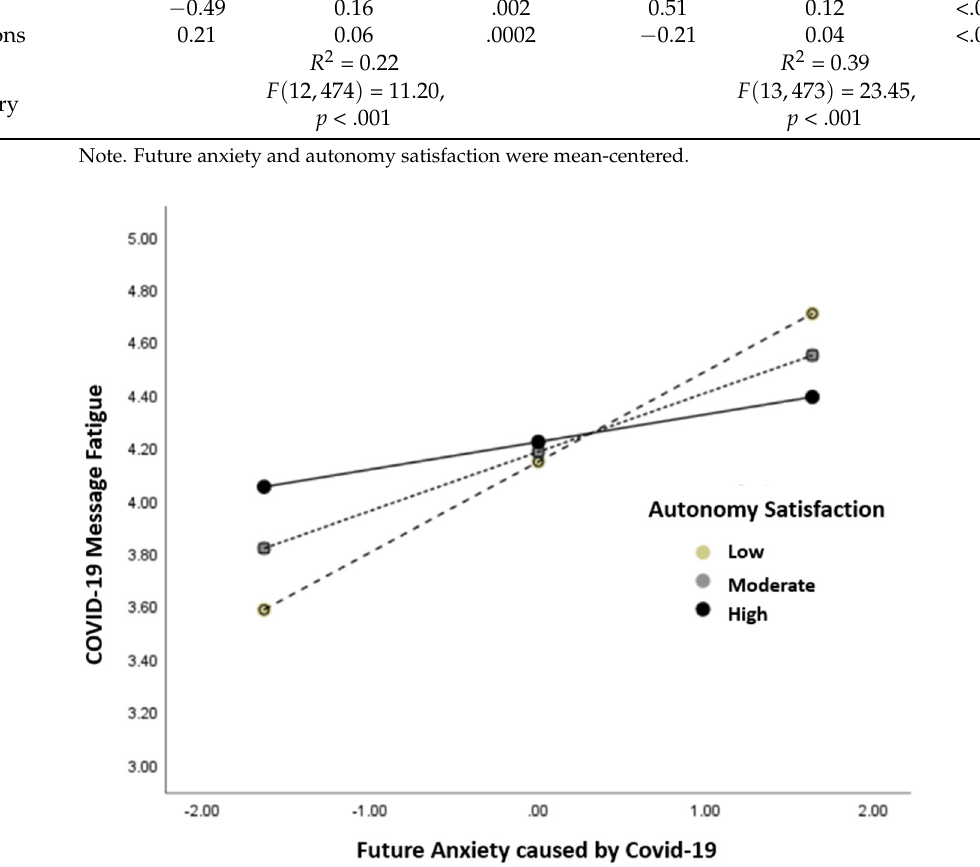
Table 2. Conditional direct and indirect relationships.